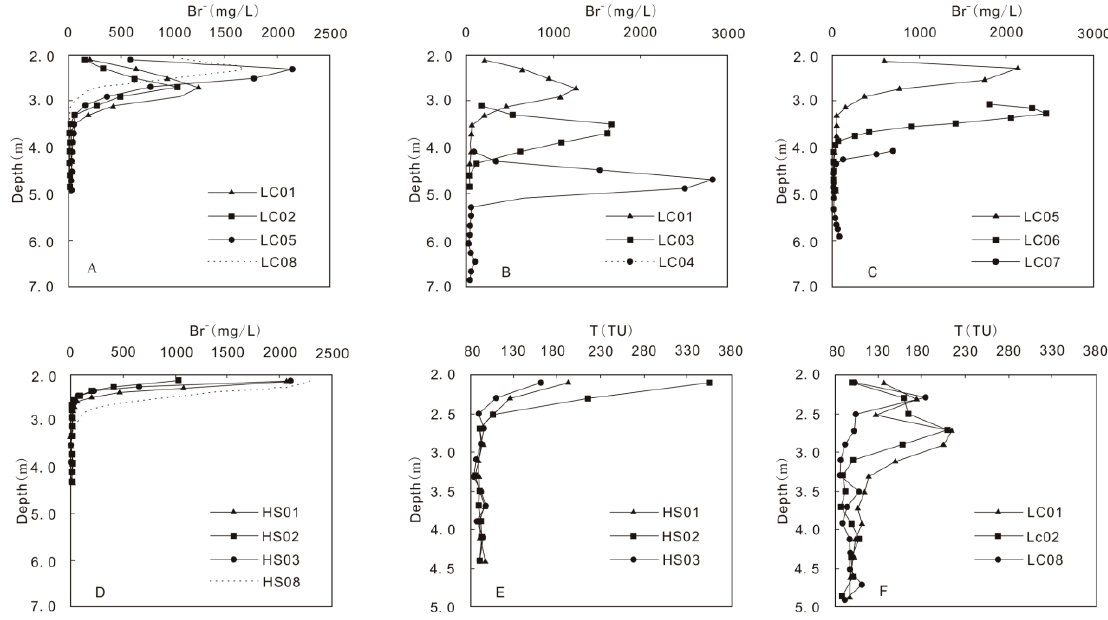
Figure 6 . Tracers’ concentration profiles in the LC and HS sites: ( A ) different land utilization in the LC site (Br − ); ( B ) different injected depths of the tracers (Br − ) in the LC site; ( C ) different injected depths of the tracers (Br − ) without human activities in the LC site; ( D ) different land utilization in the HS site (Br − ); ( E ) different land utilization in the HS site (T); ( F ) different land utilization in the LC site (T).